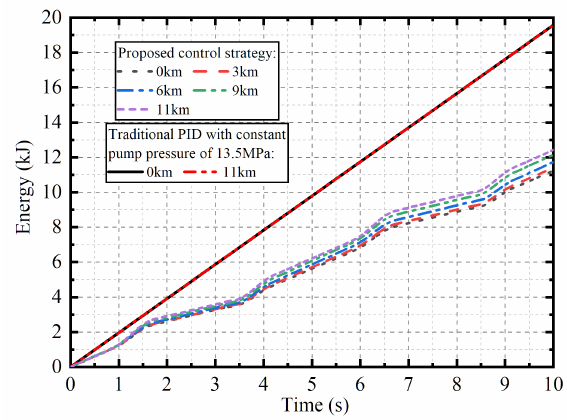
Figure 11. Energy consumption of multi-step